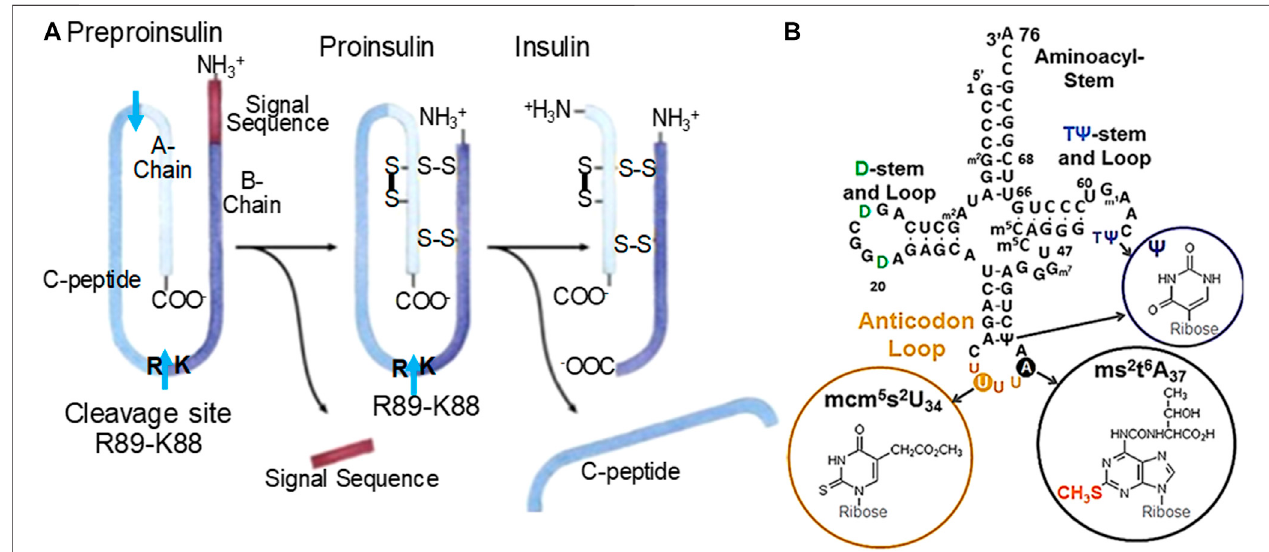
FIGURE 1 | (A) Human insulin processing. Insulin mRNA is translated into one peptide that will undergo cleavage and linkages via disul fi de bridges. One of two importantcleavage sitesisK88-R89.ApreproinsulinmRNAnecessitates tRNA Lys3 (B.) withits fullymodi fi edanticodonloop nucleosidestoaccuratelyread theLysAAG codon. Theresultingpeptideiscomposedofasignalsequence,A-chain,B-chainandC-peptide,theA-andB-chainassociateintomatureinsulin. (B) Human tRNA Lys3 . tRNA Lys3 decodes AAAand AAG inmRNA on theribosome.The ms 2 -modi fi cation oft 6 A 37 results inms 2 t 6 A 37 and is theproduct ofCdkal1 enzymatic activity. The modi fi cation ms 2 t 6 A 37 facilitates accurate and ef fi cient decoding of the lysine codons. Domains are labeled. Anticodon loop modi fi ed nucleosides positions and structures are circled. The ms 2 -modi fi cation made by Cdkal1 is found with ms 2 t 6 A 37 . The anticodon 5 ′ -adjacent invariant U and 3 ′ -modi fi ed adenosine are noted.